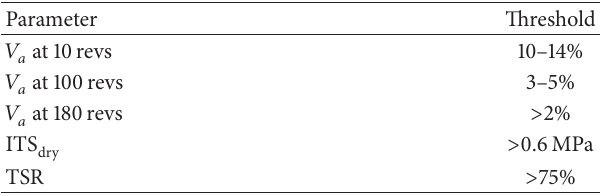
Table 1: Mix design acceptance